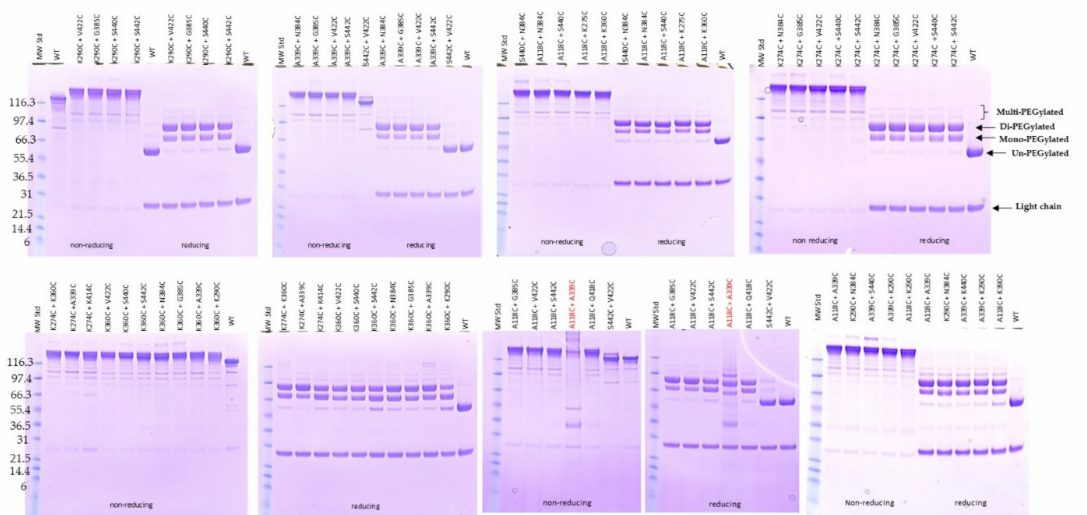
Figure 6. SDS-PAGE analysis of PEGylated double cysteine mutants. 38 unpaired double cysteine mutants were PEGylated and applied to 4–12% Bis-Tris NuPAGE under non-reducing and reducing conditions. The gels were stained with Coomassie blue. The wild-type antibody was also PEGylated and run together as controls. The lanes with protein molecular weight standard are labeled as MW Std with different kDa as shown on left of the gels. The initial clone for mutant, A118C + A339C (highlighted in red), showed poor expression and diffuse bands after PEGylation. It was re-sequenced and found to have a sequence mismatch. A second clone for A118C + A339C with the correct sequence was expressed and PEGylated as shown (labelled in black). The labels related to identities of the different species are shown on the right side of top gel under reducing